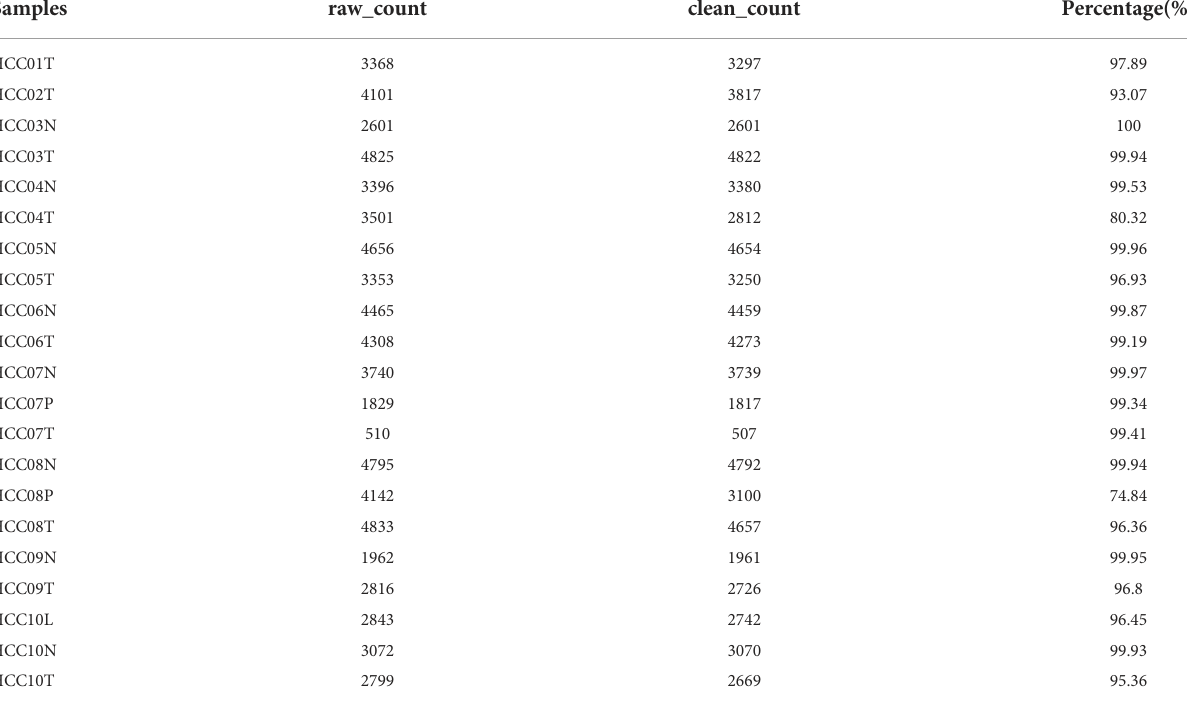
TABLE 1 Cell counts before and after fi ltration of samples.